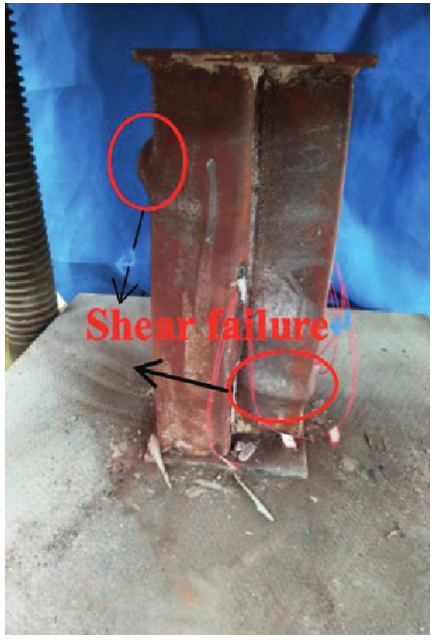
Figure 12: Shear failure.